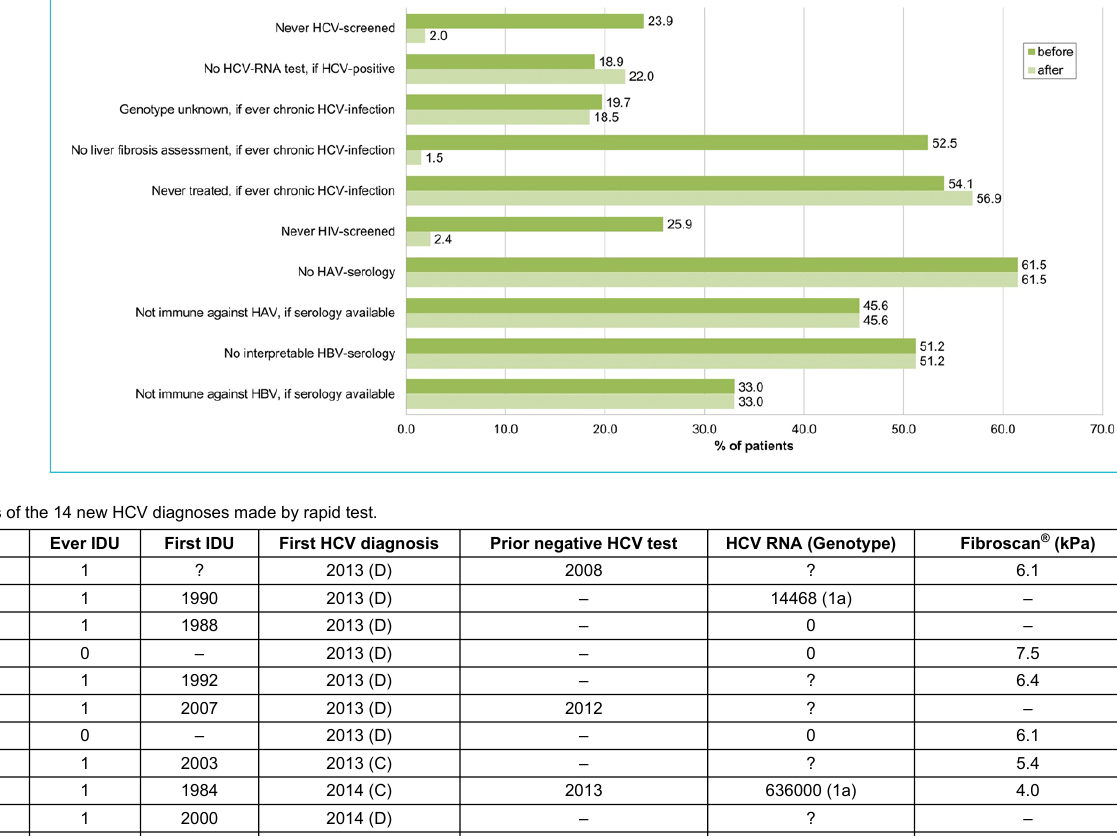
Figure 3: Proportion of patients not evaluated according to guidelines (total study population, n = 205), before and after HCV–rapid tests and Fibroscan ® within our study.HCV = hepatitis C virus; HIV = human immunodeficiency virus; HAV = hepatitis A virus; HBV = hepatitis B virus;